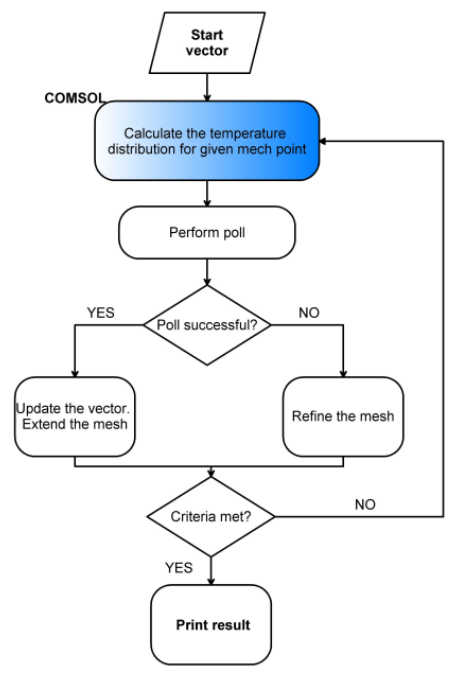
Figure 7. The chart flow of the optimization algorithm.